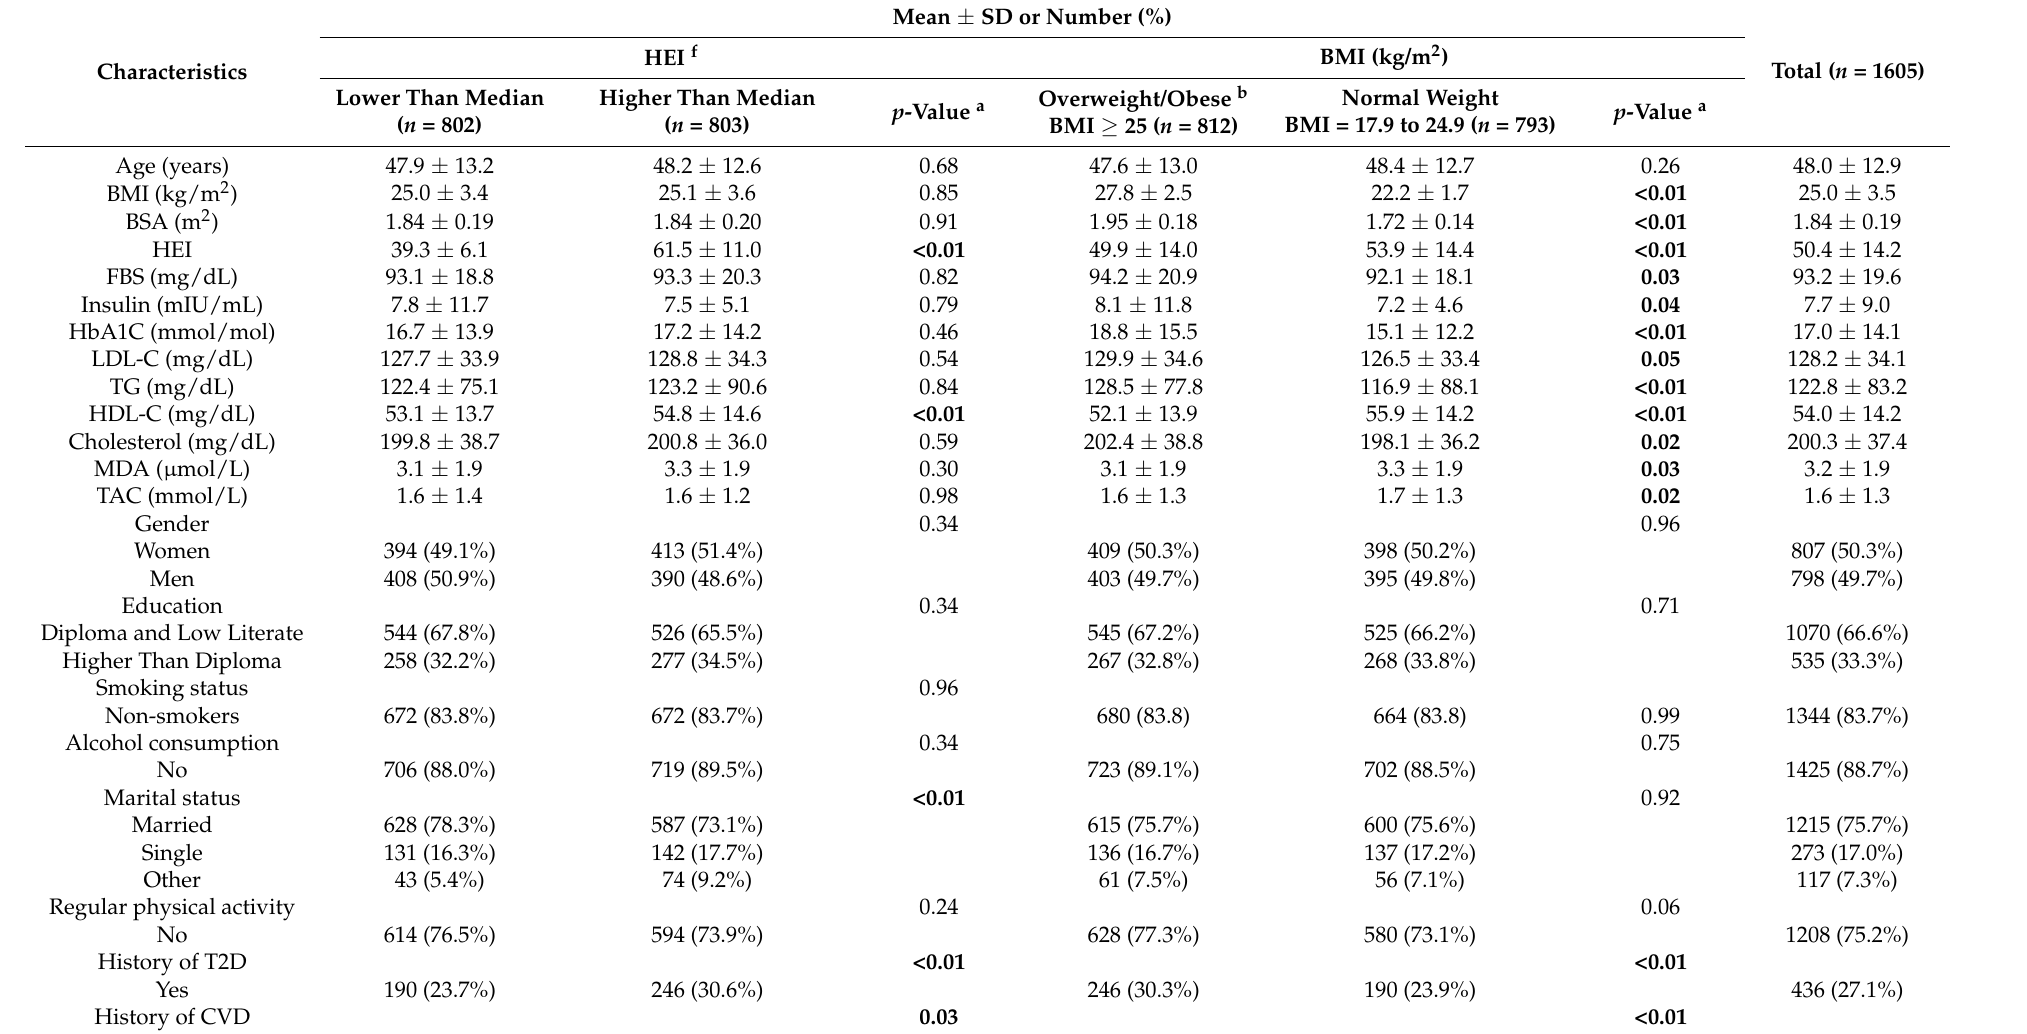
Table 1. Distribution (mean ± SD or number (%)) of socio-demographic and serum variables across HEI and BMI